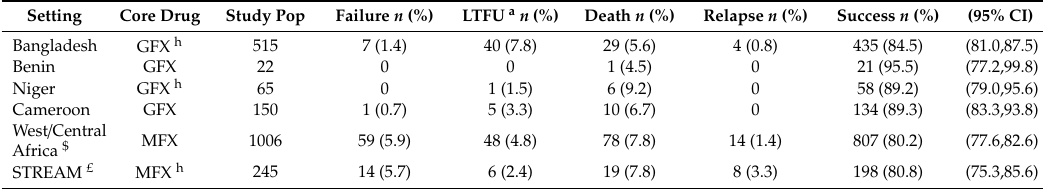
Table 2. Outcomes reported in published studies on short-course regimens.